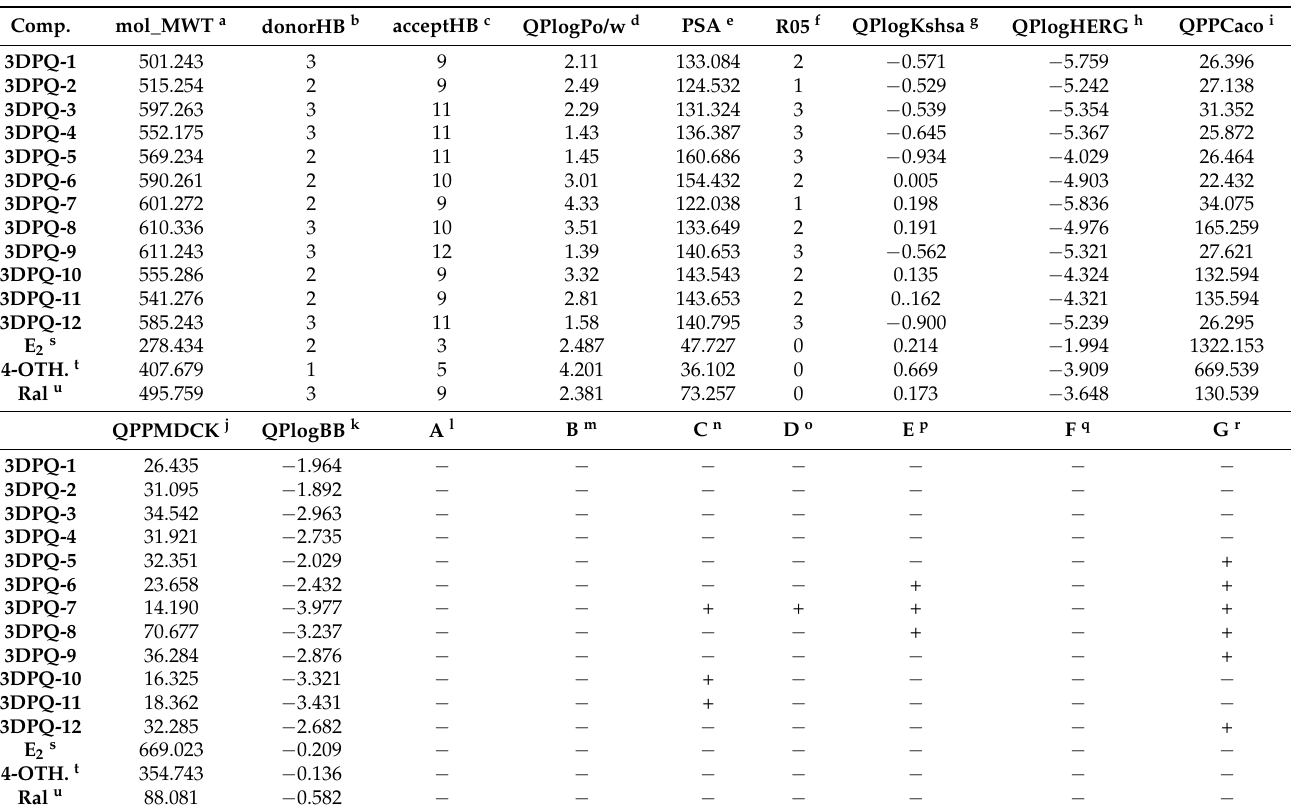
Table 10. In silico physicochemical and pharmacokinetic properties of synthesized